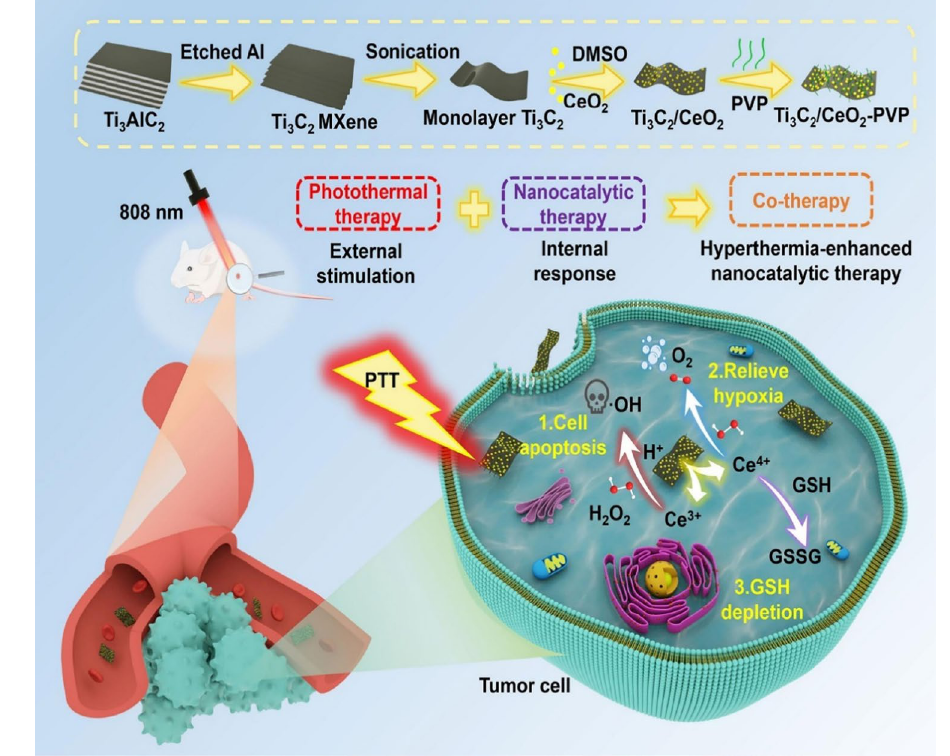
Fig. 2 MXene (Ti 3 C 2 )/CeO 2 -polyvinylpyrrolidone nanocomposites with photothermal effects, strong catalytic activities, and glutathione degra- dation capabilities exhibited suitable applicability for hyperthermia-enhanced tumor combinational therapy (in vivo). DMSO dimethyl sulfoxide, PTT photothermal therapy, GSH glutathione, PVP polyvinylpyrrolidone. Reproduced with permission from Ref. [71]. Copyright 2022